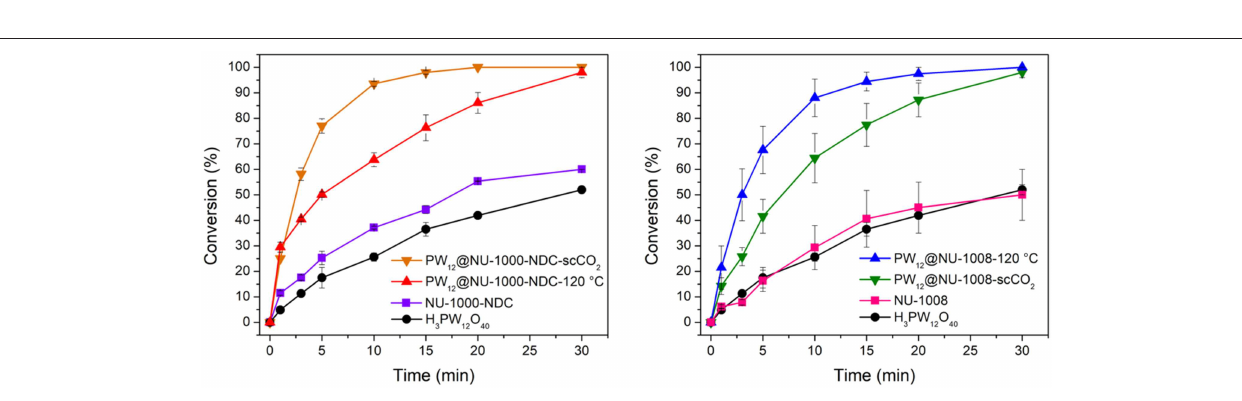
mmol) was added to the solution and sonicated for 1 min. The mixture was allowed to sit for 3 days, with occasional